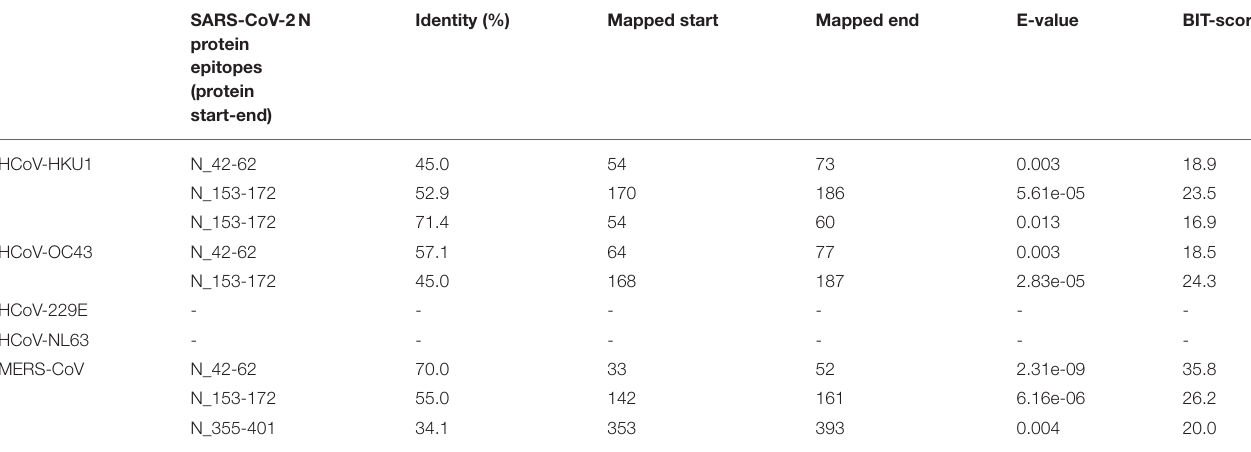
TABLE 7 | Sequence identity of N protein of human alpha- and beta-coronaviruses against SARS-CoV-2-derived B-cell epitopes (evaluated by blastp). SARS-CoV-2N